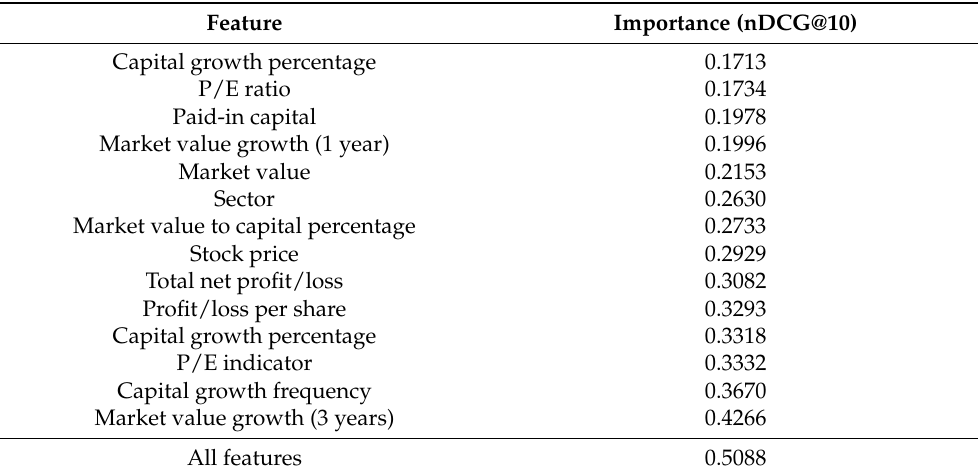
Table 12. Feature importance is estimated by training a model for each feature and reporting